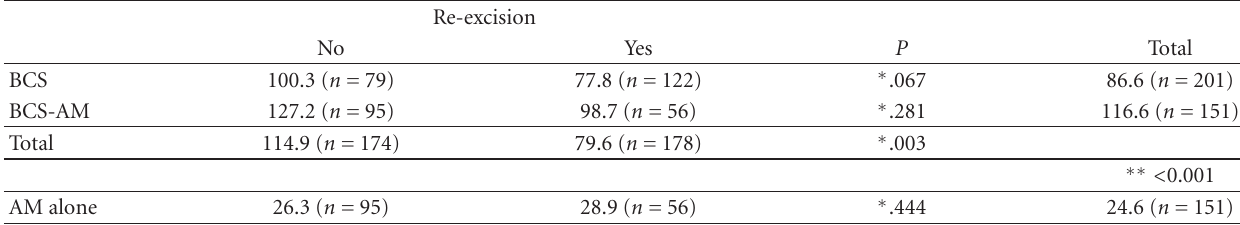
(a) Comparison of the average total volume of BCS and BCS-AM surgery relative to re-excision surgery.